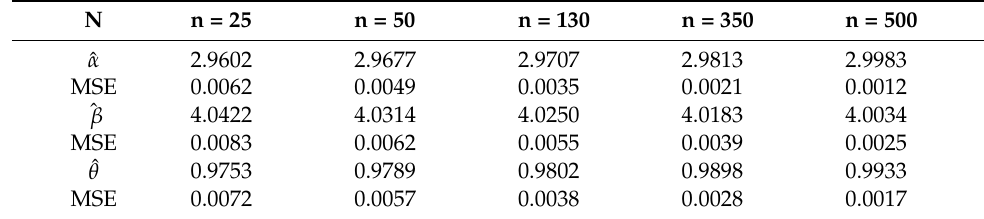
Table 4. Mean simulated values of the MLEs of ˆ γ with corresponding MSE.